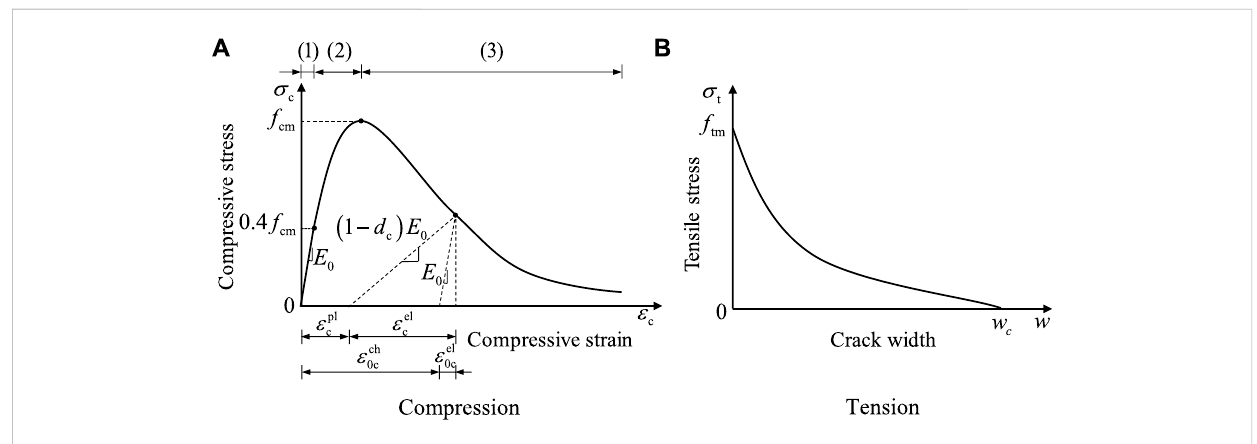
FIGURE 10 Concrete uniaxial behaviour. (A) Compression (B) Tension.